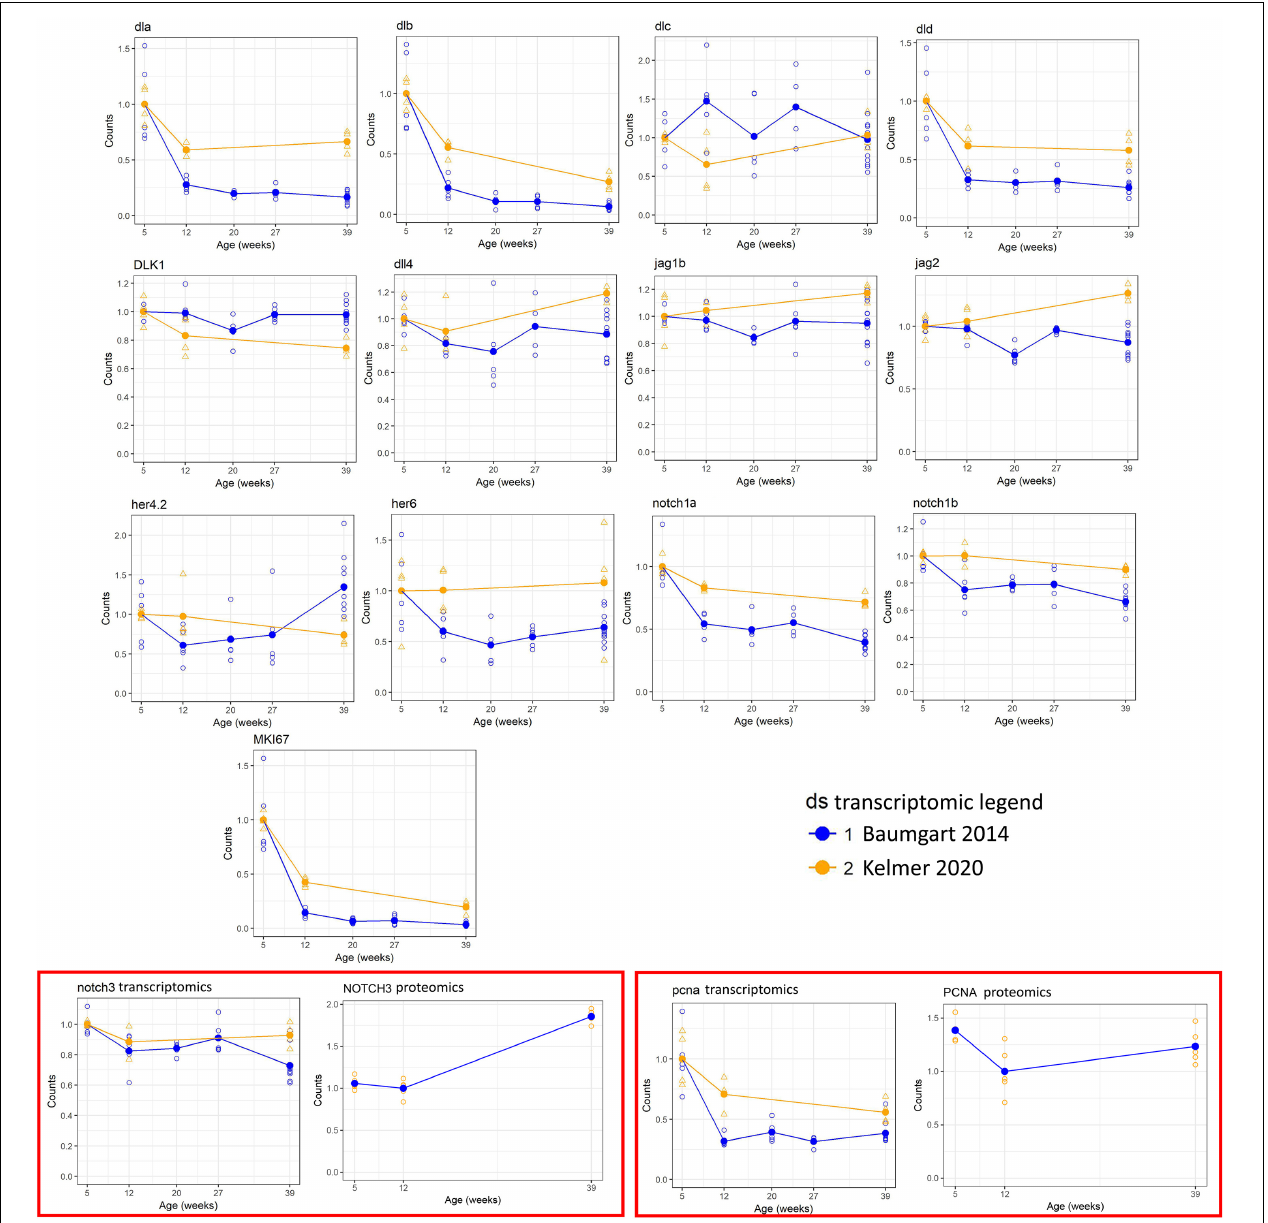
FIGURE 1 | Expression of selected genes of the Notch pathway measured by RNA sequencing (RNA-seq). For each gene, the Spearman correlation coefficient, the uncorrected p -value, and the corrected p -value are shown. For correction of the p -value, only genes mapping to the Kyoto Encyclopedia of Genes and Genomes (KEGG) pathway dre00430 were used. Open circles represent single samples, and the solid circle represents the mean within an age step. Across-sample normalization of counts was performed using the normalization procedure of